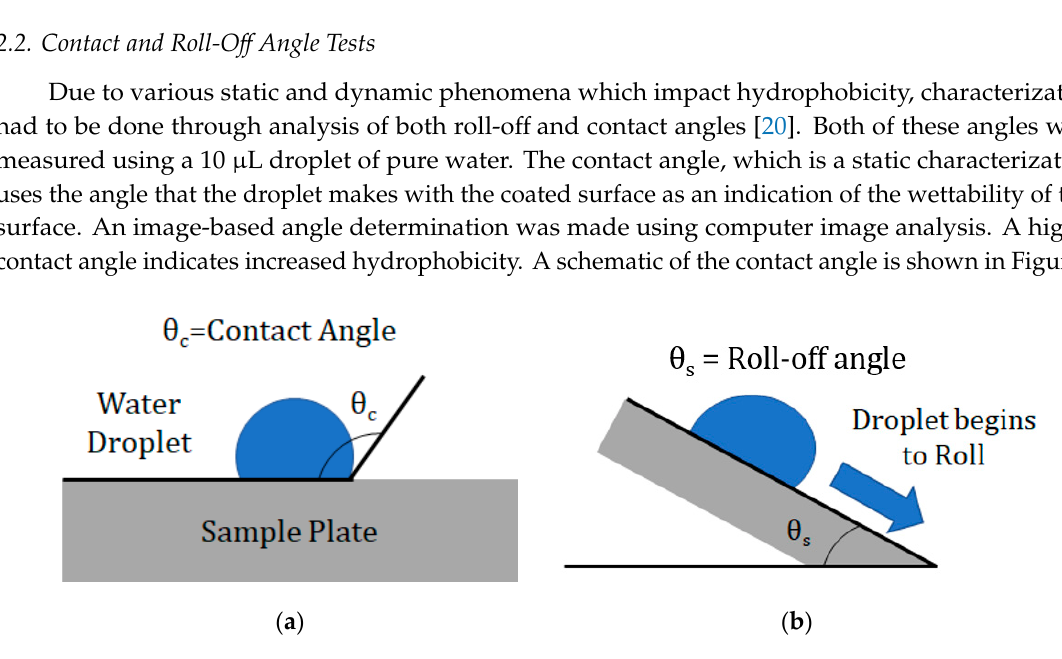
Figure 1. ( a ) Contact angle schematic; ( b ) roll-off angle